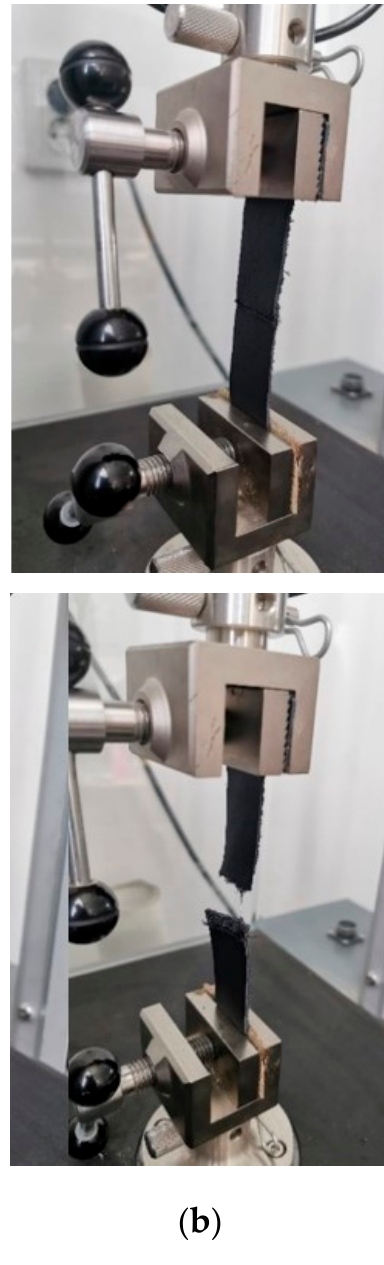
Figure 2. ( a ) Shape and dimensions of the stitched samples (S2 a, b, c, d); and ( b ) stitched sample position in the testing machine. Before and after testing.